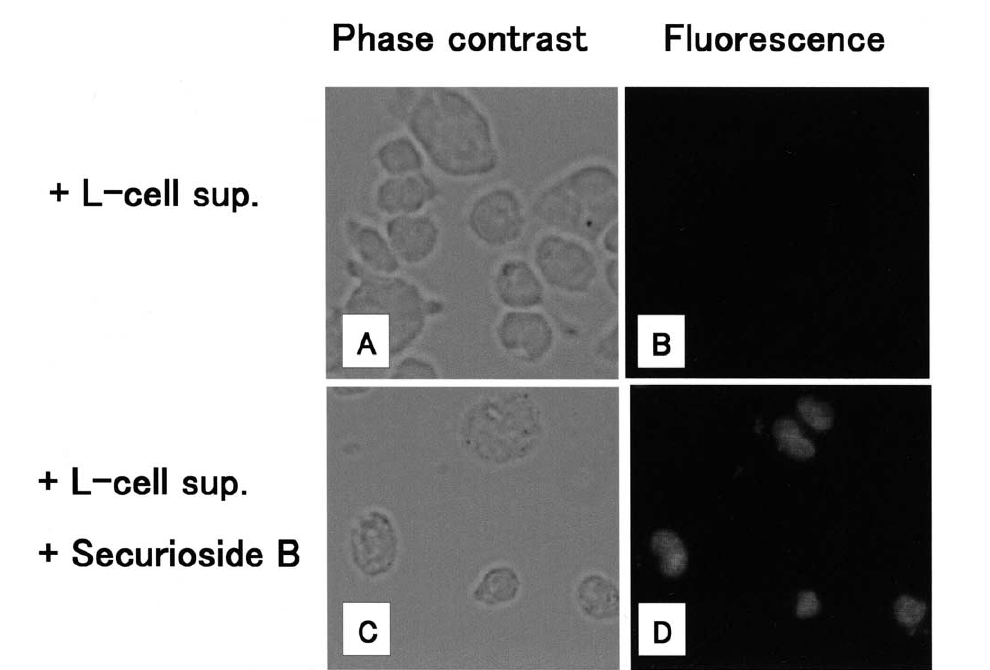
FIG. 2. Analysis of the DNA cleavage of the cultured BAC1.2F5 cells. The cells were cultured without (A, B) or with (C, D) 10 m g/ ml securioside B in the presence of 20% L-cell-conditioned medium for 3 days. The cells were stained by the TUNEL method and observed with phase contrast microscopy (A, C). DNA breaks represented by fluorescein were detected by fluorescence microscopy (B,